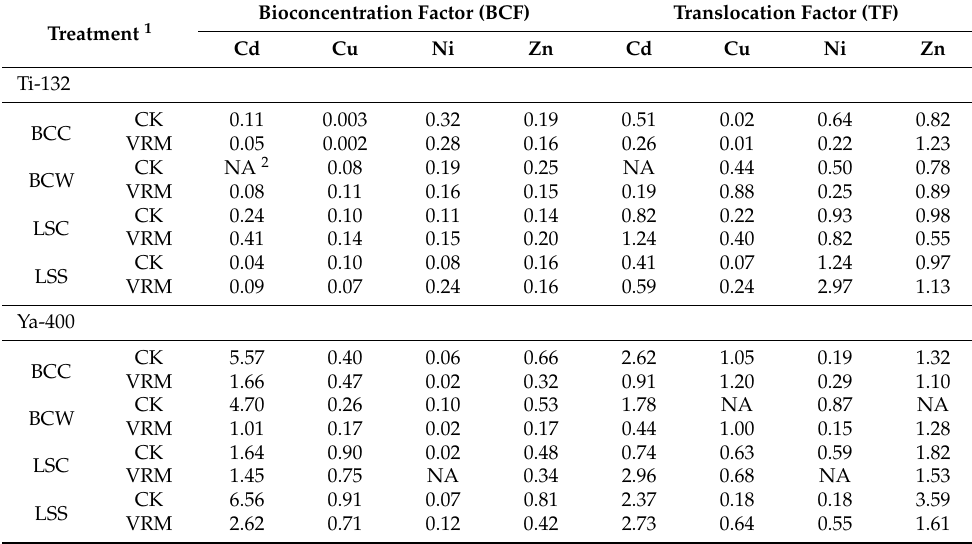
Table 3. The bioconcentration factors (BCFs) and translocation factors (TFs) of Cd, Cu, Ni, and Zn for pak choi and lettuce grown in Ti-132 and Ya-400 soil under different treatments. Bioconcentration Factor (BCF) Translocation Factor (TF) Treatment 1 Cd